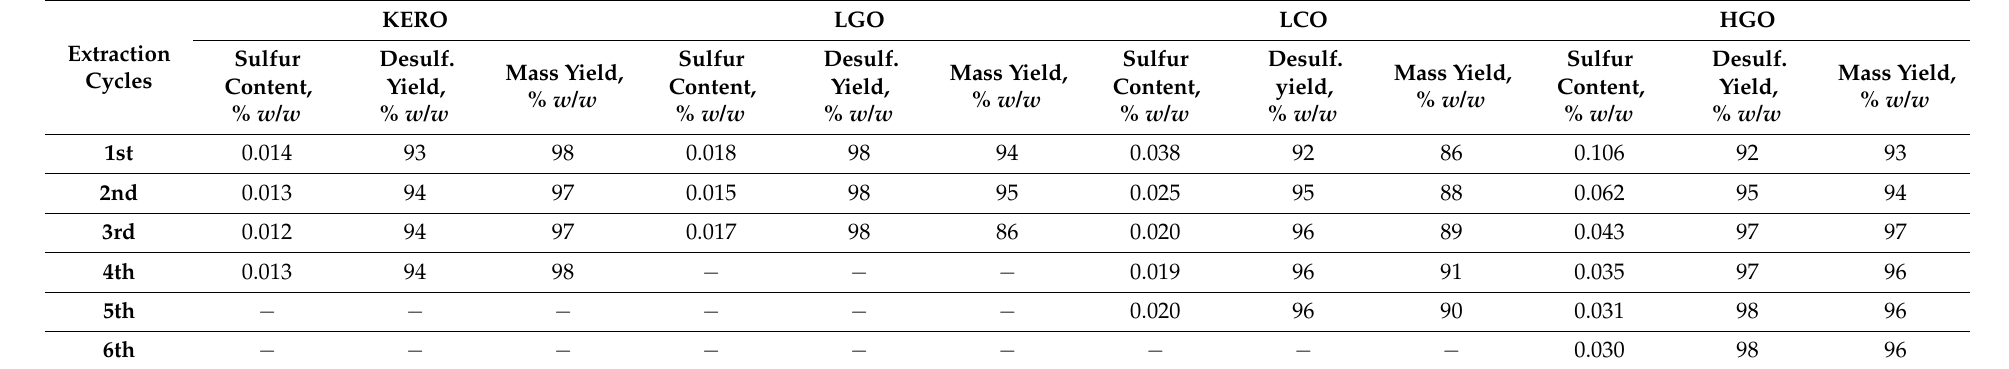
Table 10. Sulfur content, desulfurization yield and mass yield of the surrogate raffinates during the multiple-stage extractions with recycled [BMIM][Br].